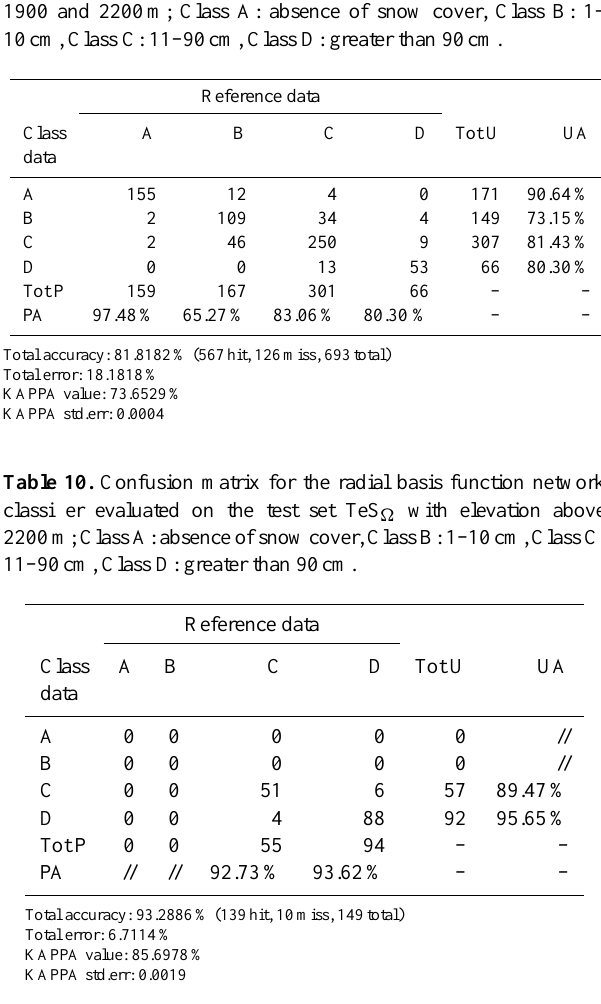
Table 9. Confusion matrix for the radial basis function network classifier evaluated on the test set TeS (cid:127) with elevation between 1900 and 2200m; Class A: absence of snow cover, Class B: 1–